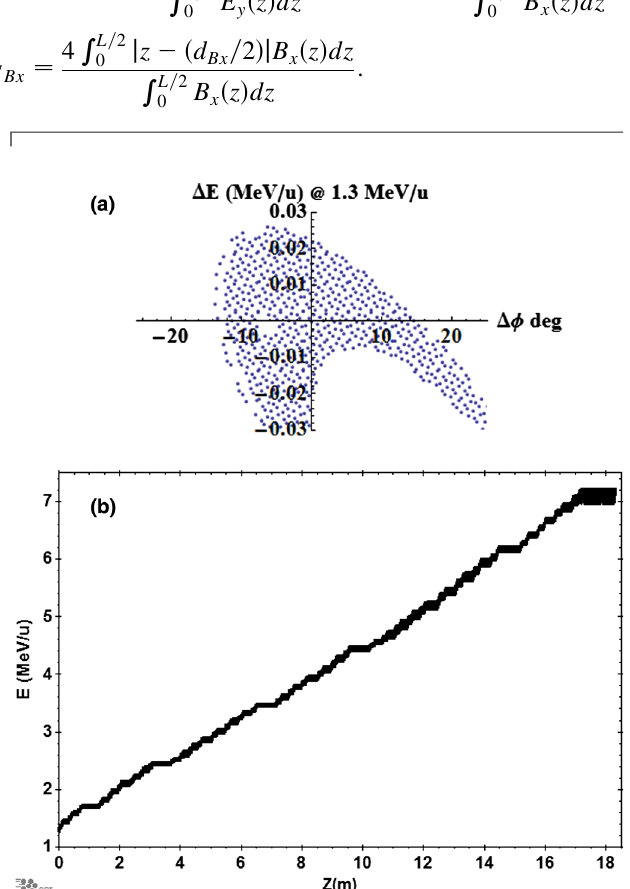
FIG. 12. (a) Longitudinal acceptance ellipse of entire beam line consisting of 36 resonators. (b) Energy variation along the